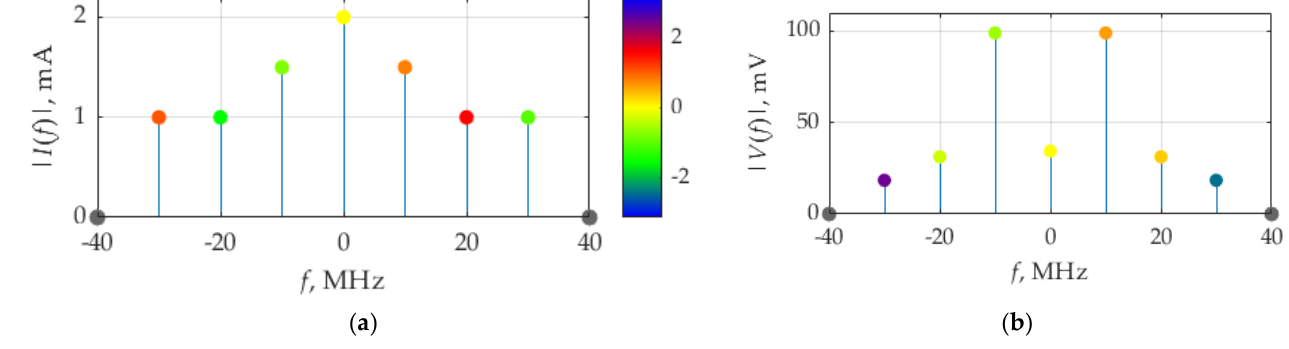
Figure 3. The current ( a ) and voltage ( b ) spectra for the case of finite sum of harmonics current. It can be seen in Figure 3b that, for the voltage spectra, the maximum in absolute value weights of the delta function are at frequencies ± 10 MHz, which correspond to the circuit resonant frequency, f r , and the fundamental frequency, F , of considered signals. Figure 4 shows the weights of two-dimensional Dirac delta functions, forming the bifrequency spectrum, S vi ( f 1 , f 2 ), of the current, i ( t ), and the voltage, v ( t ), in accordance with (15). These delta functions are arranged with step 10 MHz, which corresponds to the fundamental frequency, F , of signals i ( t ), v ( t ) and p ( t ). It can be seen that the section of S vi ( f 1 , f 2 ) at f 1 = ± 10 MHz have maximum weights.